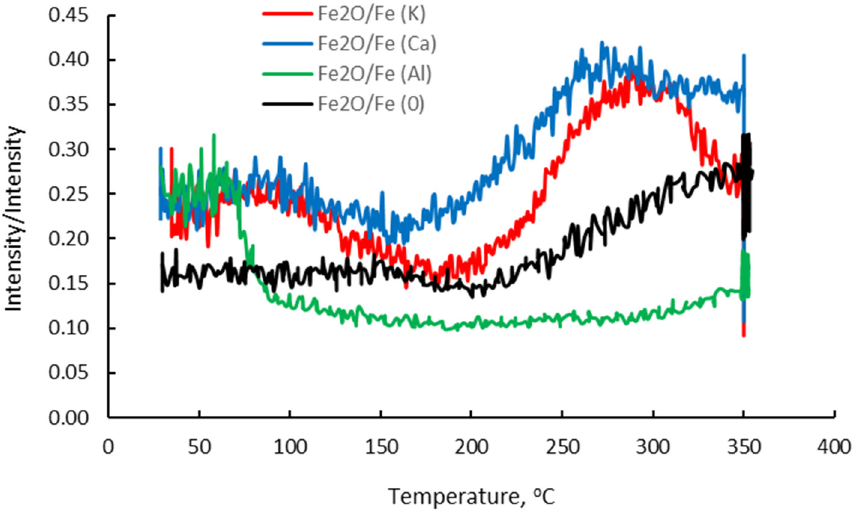
Figure 3. Changes in Fe 2 O/Fe ratio of the iron samples wetted with potassium, calcium and alumi- num and the reference sample (without promoters).